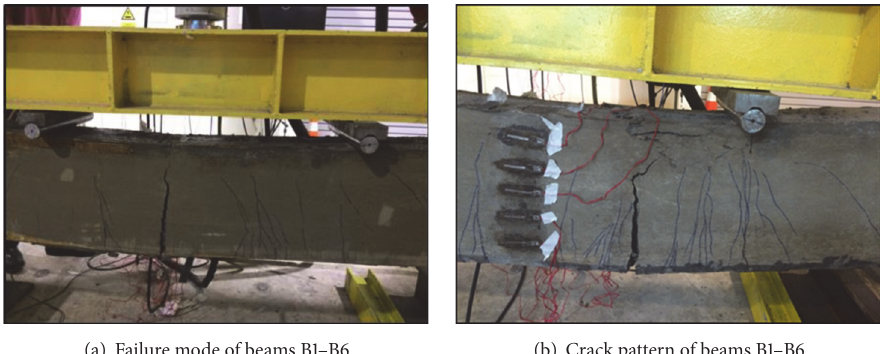
Figure 9: Typical flexural failure modes for beams B1 to B6.